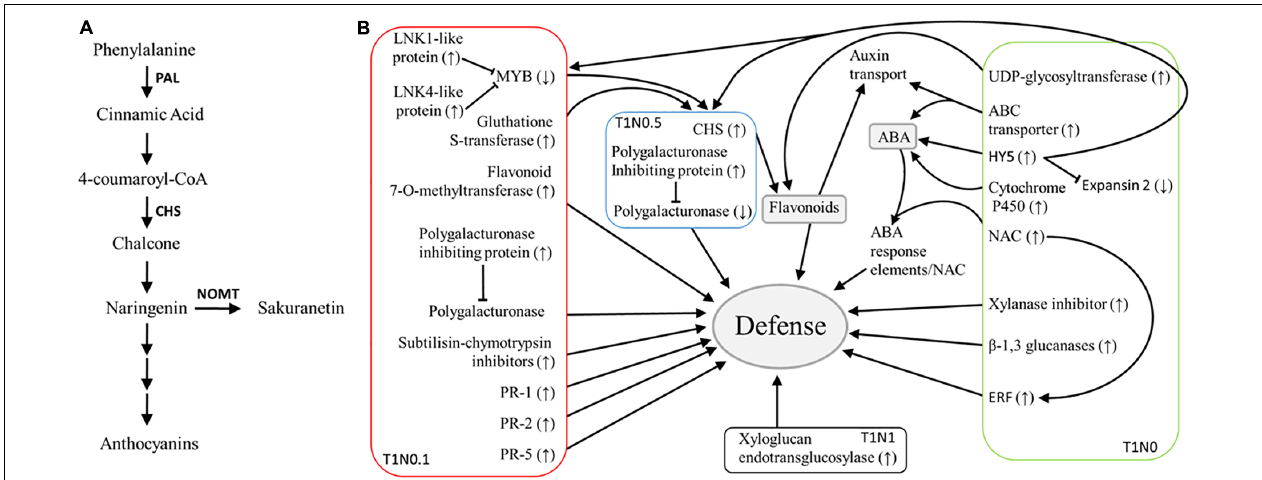
FIGURE 4 | Schematic representation of defense activation by Trichoderma harzianum T34 in wheat seedlings. (A) Scheme of the major branch pathway of flavonoid biosynthesis, seven genes differently expressed in wheat seedling roots resulting from the GeneChip Wheat Genome Array analysis under different growth conditions with Trichoderma harzianum T34 and 0 (T1N0, green), 0.1 (T1N0.1, red), 0.5 (T1N0.5, blue) or 1 (T1N1, black) mM calcium nitrate belong to this pathway. Enzyme names are abbreviated as follows: Chalcone synthase (CHS), Naringenin 7- O -methyltransferase (NOMT) and Phenylalanine ammonia-lyase (PAL). (B) Signaling networks involving major genes related to plant- Trichoderma interaction that show upregulation ( ↑ ) or downregulation ( ↓ ) in the current study.